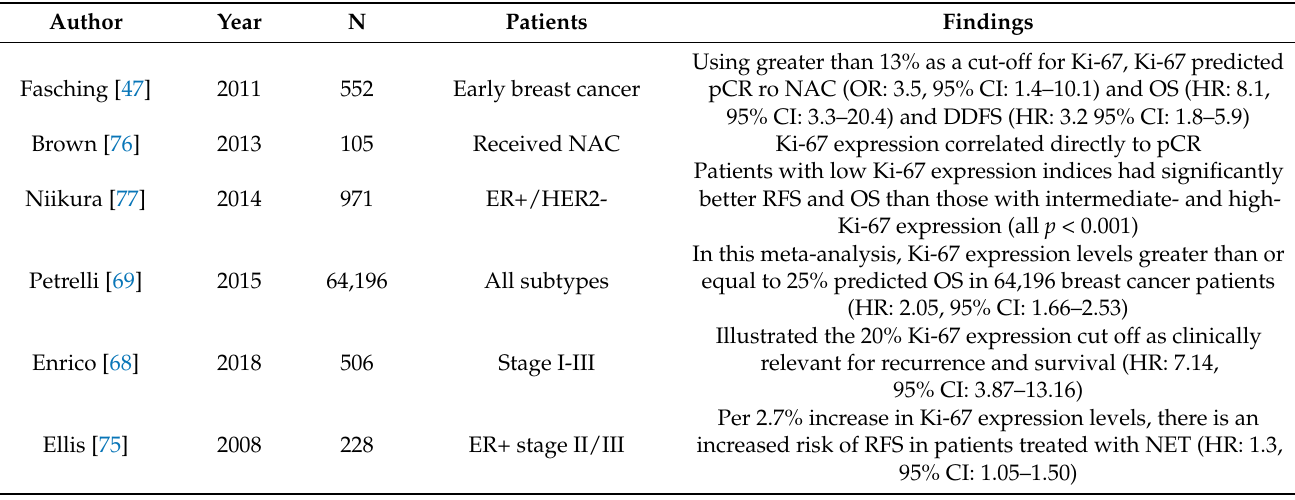
Table 1. Studies assessing the validity of Ki-67 as a biomarker in invasive breast